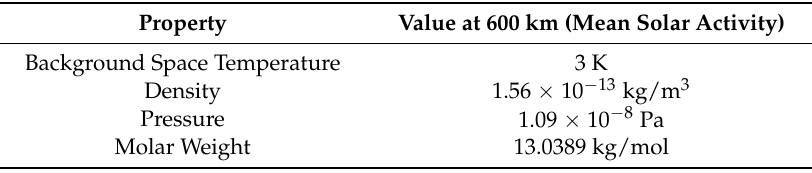
Table 3. Atmospheric Properties at a 600 km Altitude with mean solar activity